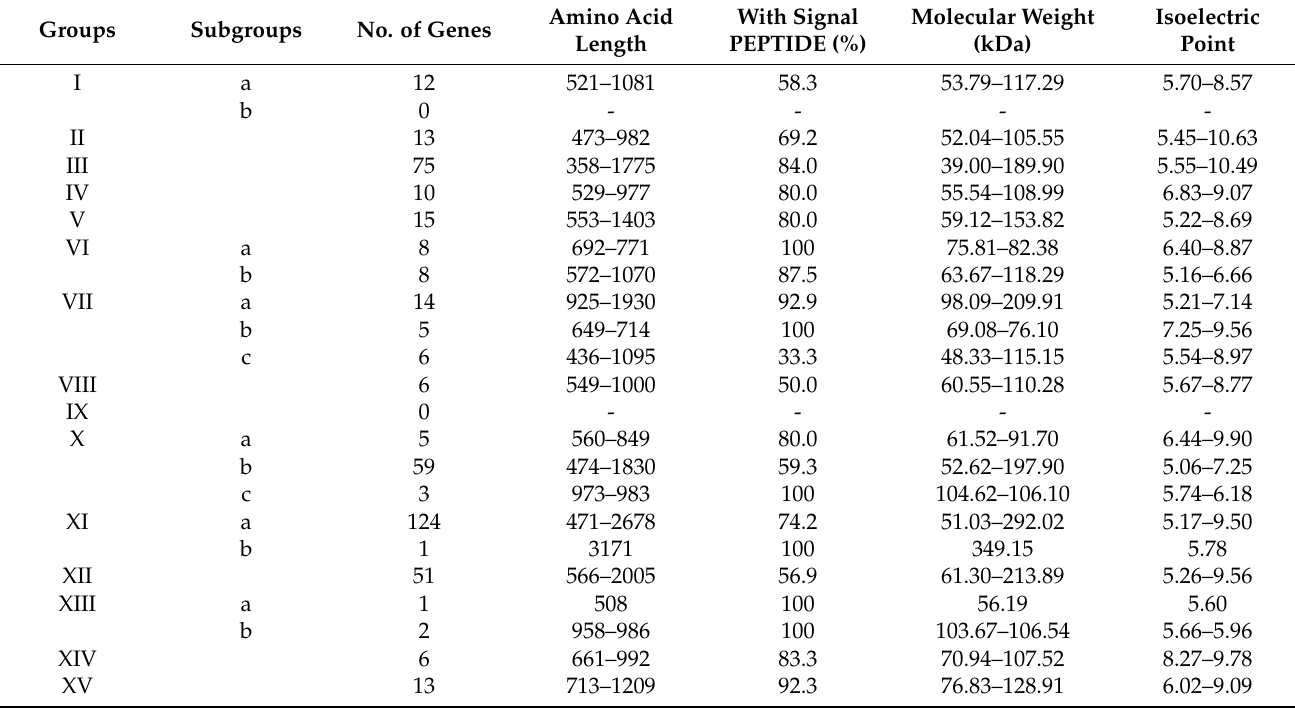
Table 1. LRR-RLK proteins in Saccharum spontaneum and their key